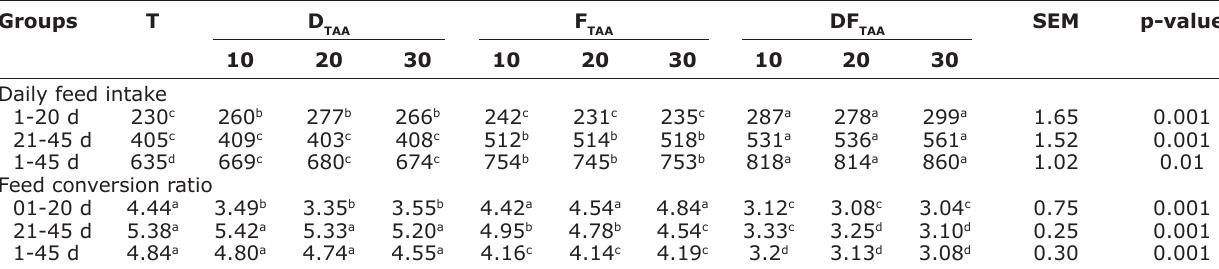
Table-5: Effects of substitution of soybean meal with apricot kernel cake on daily feed intake (DFI in g/subject) and feed conversion ratio of quail. Groups T D TAA